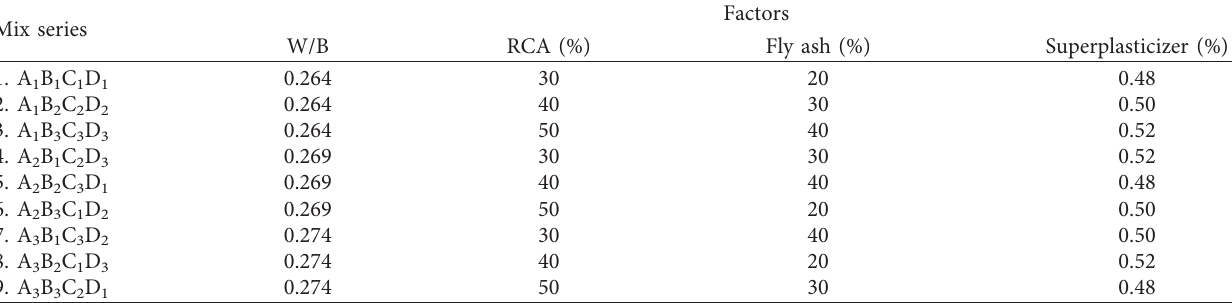
Table 7: Orthogonal test